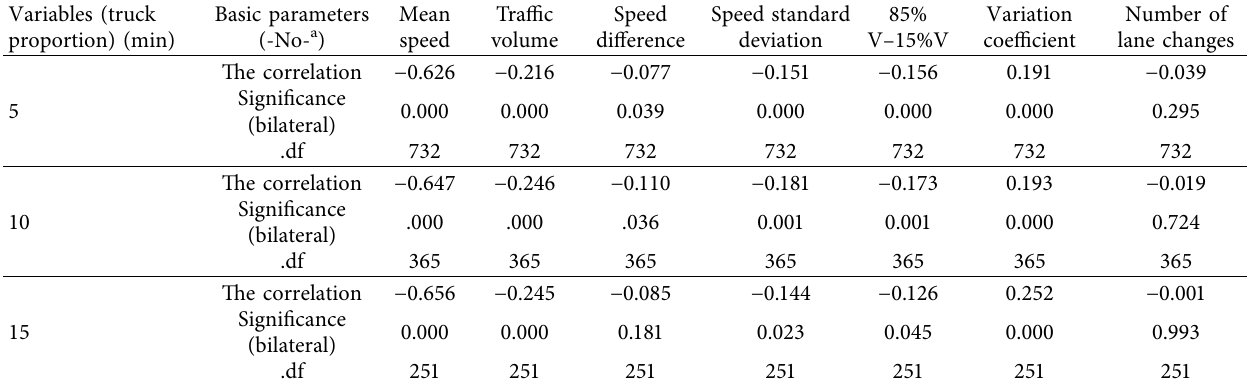
Table 3: The relationship between basic traffic flows in the correlation